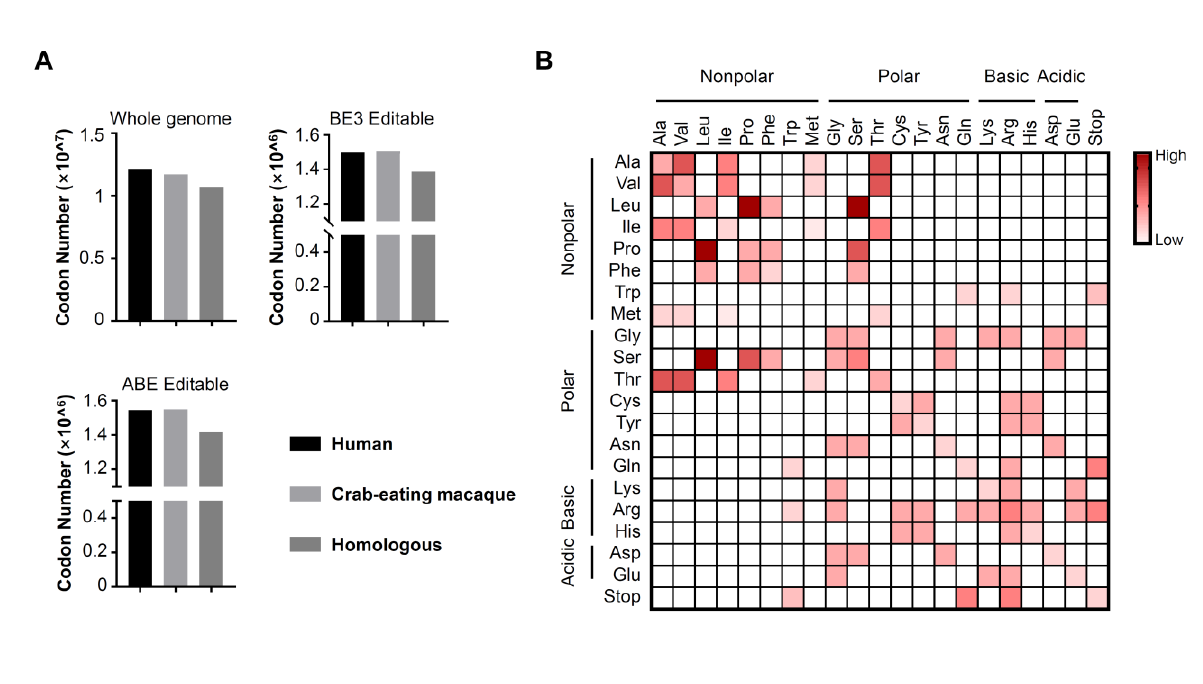
FIGURE 2: The analysis of editable codons for BEs. (A) The number of codons from NCBI database. Histograms in this panel show the number of codons of human and crab-eating macaque genomes as well as their homologous codons (Whole genome), and the number of codons from these two species editable with BE3 and ABE (BE3 Editable and ABE Editable, respectively). (B) Illustration of the repertoire of the amino acid conversions generated by BEs (BE3 and ABE). The amino acids on x axis and y axis are converted between each other. The theoretical abilities of amino acid conversions are displayed in red-white color